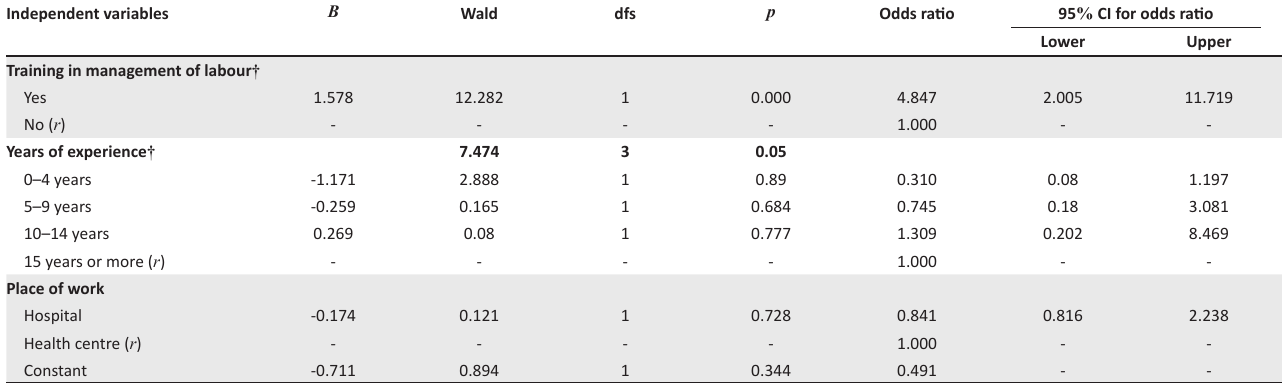
TABLE 1: Logistic regression predicting the likelihood of proper or not proper use of the partogram. Independent variables